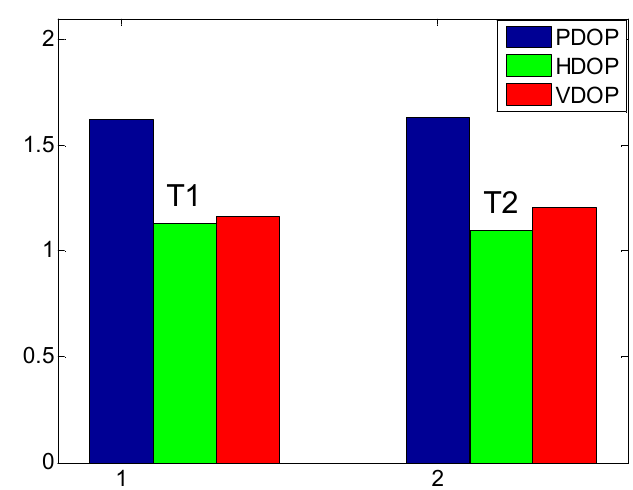
Figure 8. The frequency histograms of parameter estimator bias.